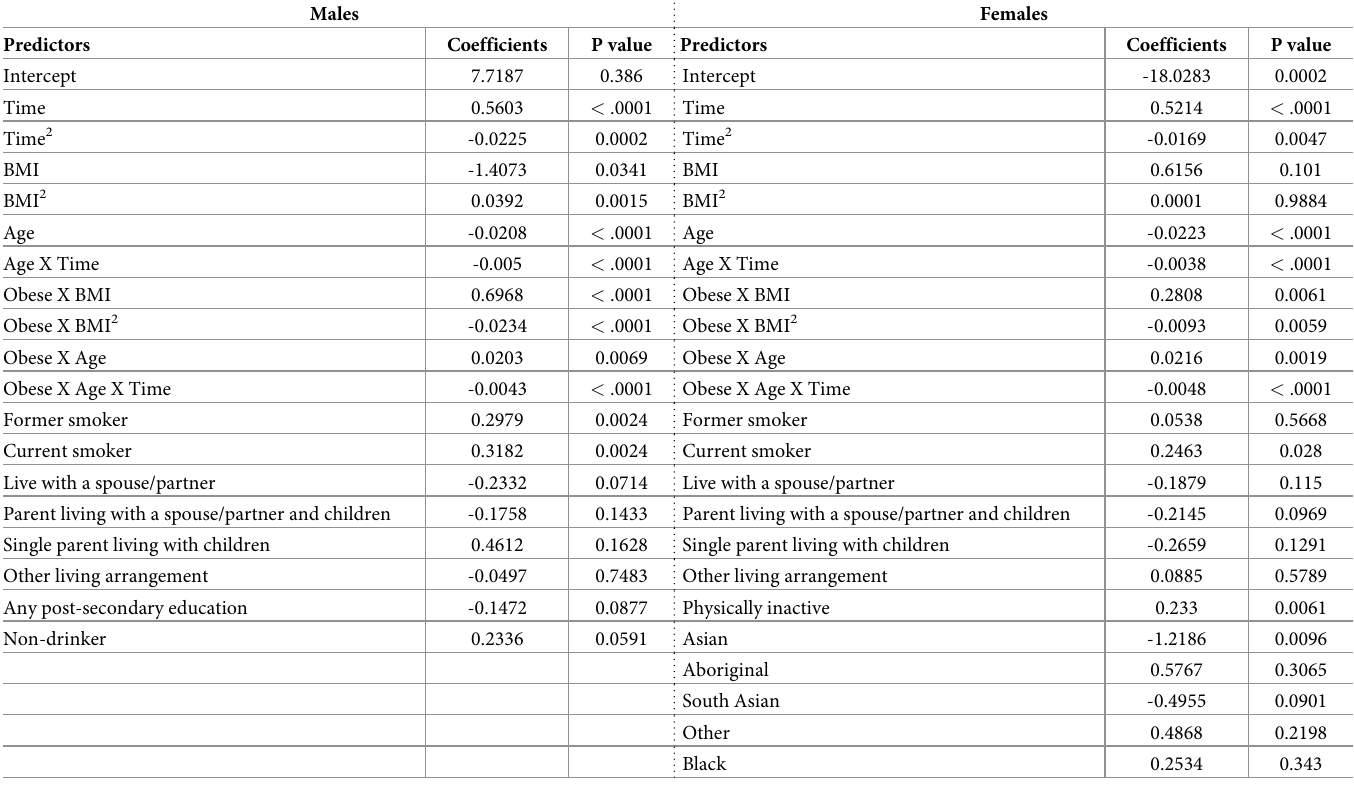
Table 2. Obesity Population Risk Tool (OPoRT) function for males and females.